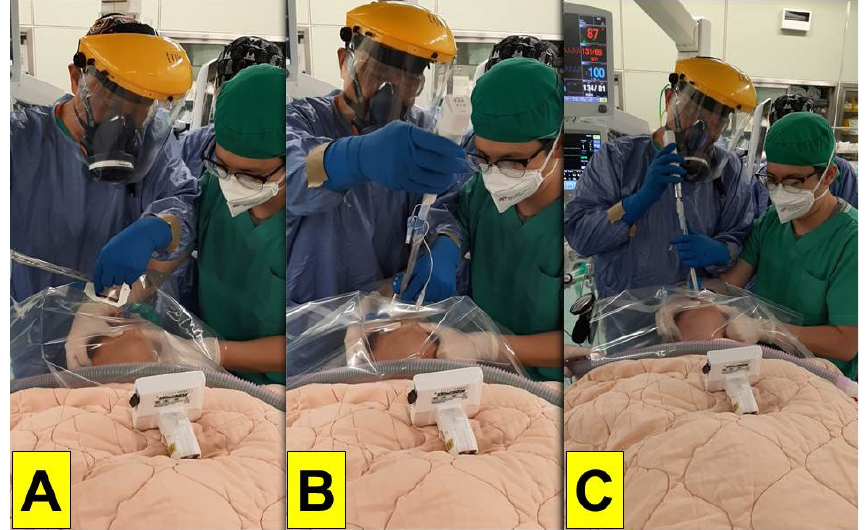
Figure 9. Application of the Shikani technique and plastic sheet barrier in the patient receiving double-lumen endobronchial tube insertion. ( A ) Entry of oral cavity; ( B ) localization of glottic area; ( C ) ready for railroading the tube into trachea. The pictorial and video demonstration can be found in Figure